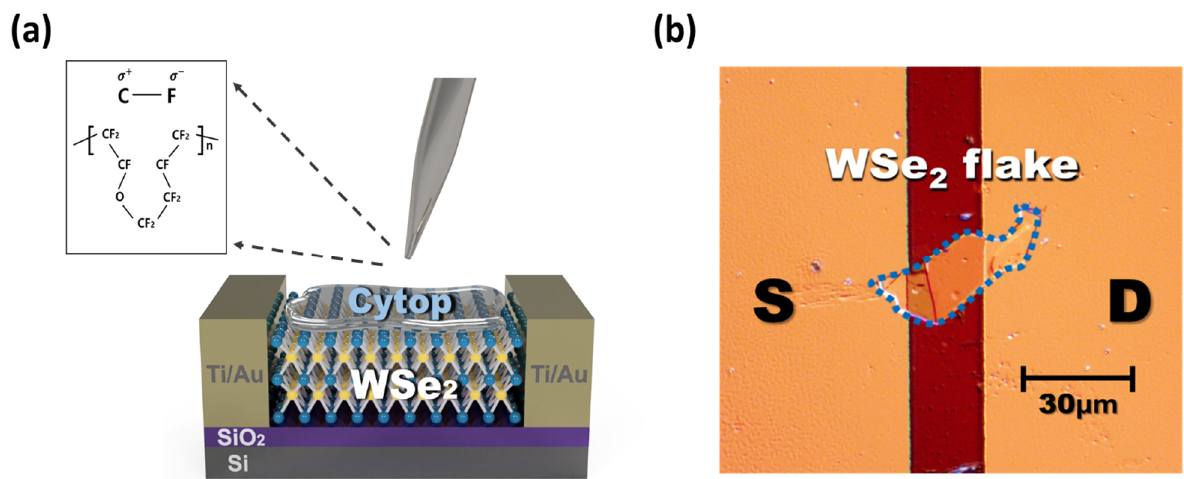
Figure 1. ( a ) Schematic of the fluoropolymer–WSe 2 composite (F-WSe 2 ) device. Inset: Chemical structure of Cytop; ( b ) optical microscopy (OM) image of the F-WSe 2 device flake.